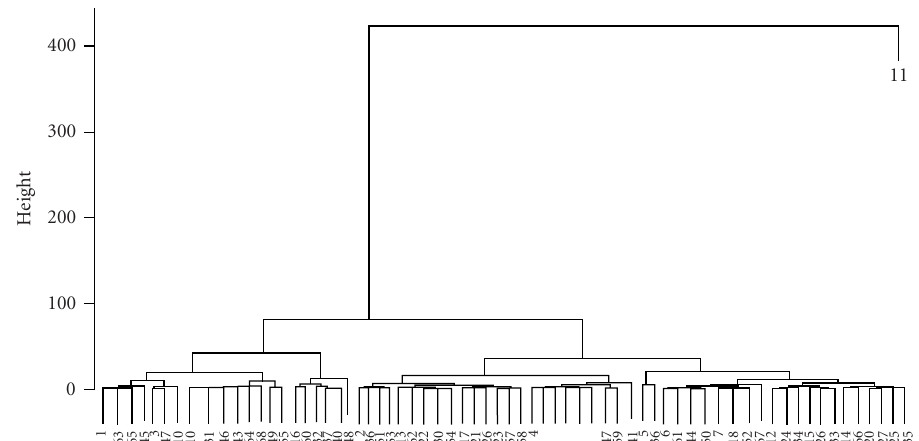
Figure 3. Clustering proteomics data with Diana.